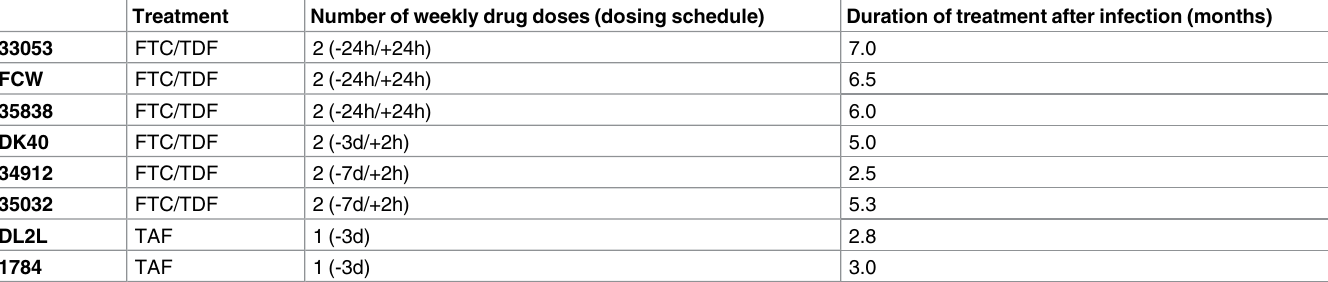
Table 1. Treatment dosing schedule and duration of treatment in PrEP breakthrough